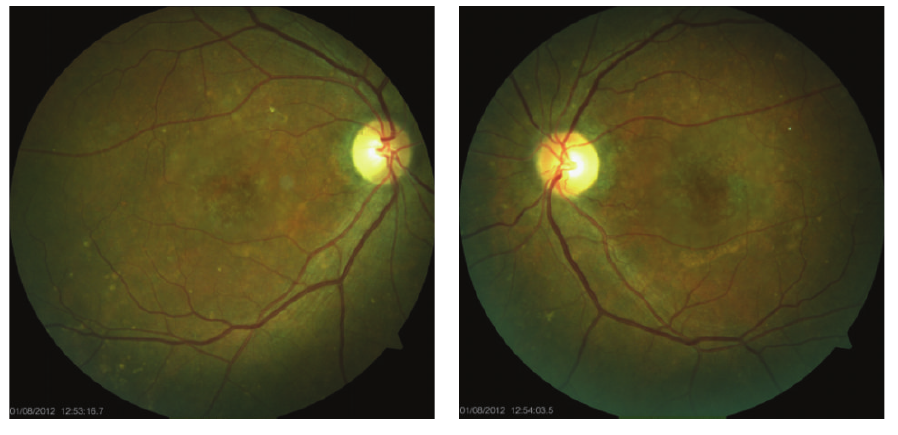
Figure 1: Ocular fundus.